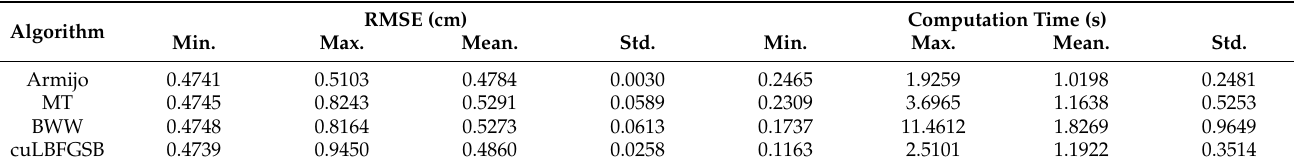
Table 8. RMSE and the computation time statistics of four candidates.